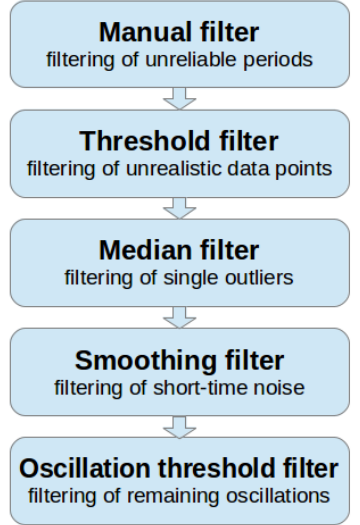
Figure 2. Flowchart of the basic processing